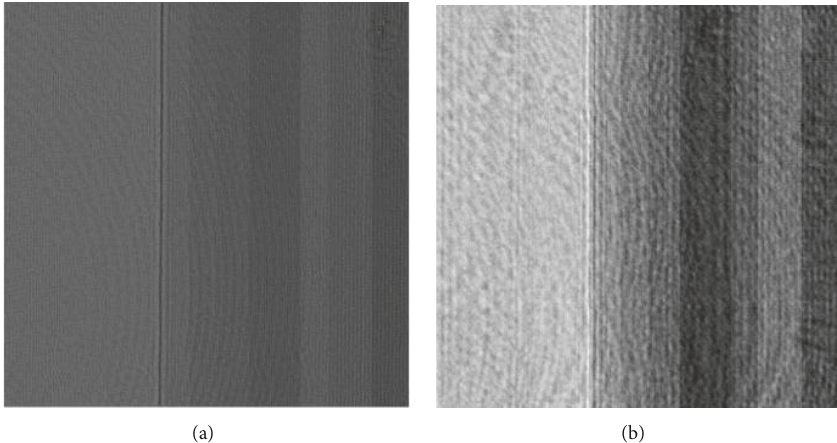
Figure 8: Experimental results with single wavelength measurement. (a) Phase image for 632.8 𝑛𝑚 , (b) phase image for 532 𝑛𝑚 .